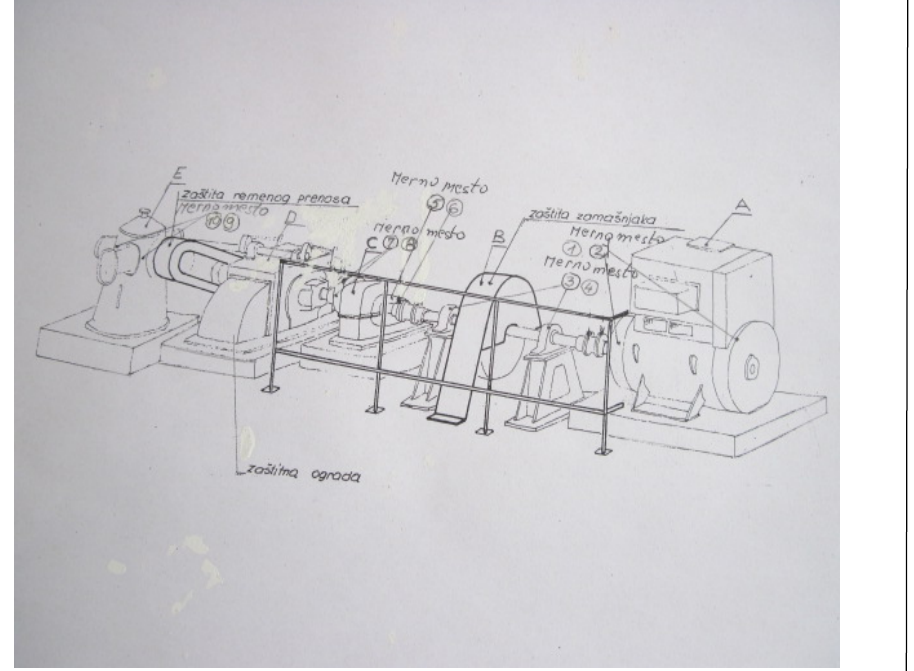
Figure 4 – Scheme of the plant and the measurement points at the mini hydropower plant Рис . 4 – Схема установки и точки замера на мини